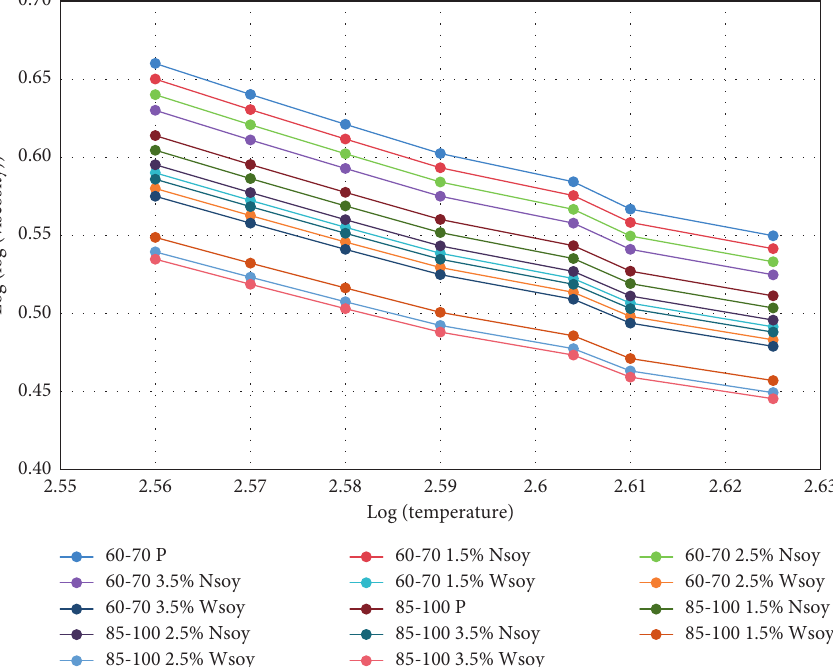
Figure 7: Viscosity Temperature Susceptibility (VTS) of unmodified and modified mixtures. Table 7: VTS of unmodified and modified binders.